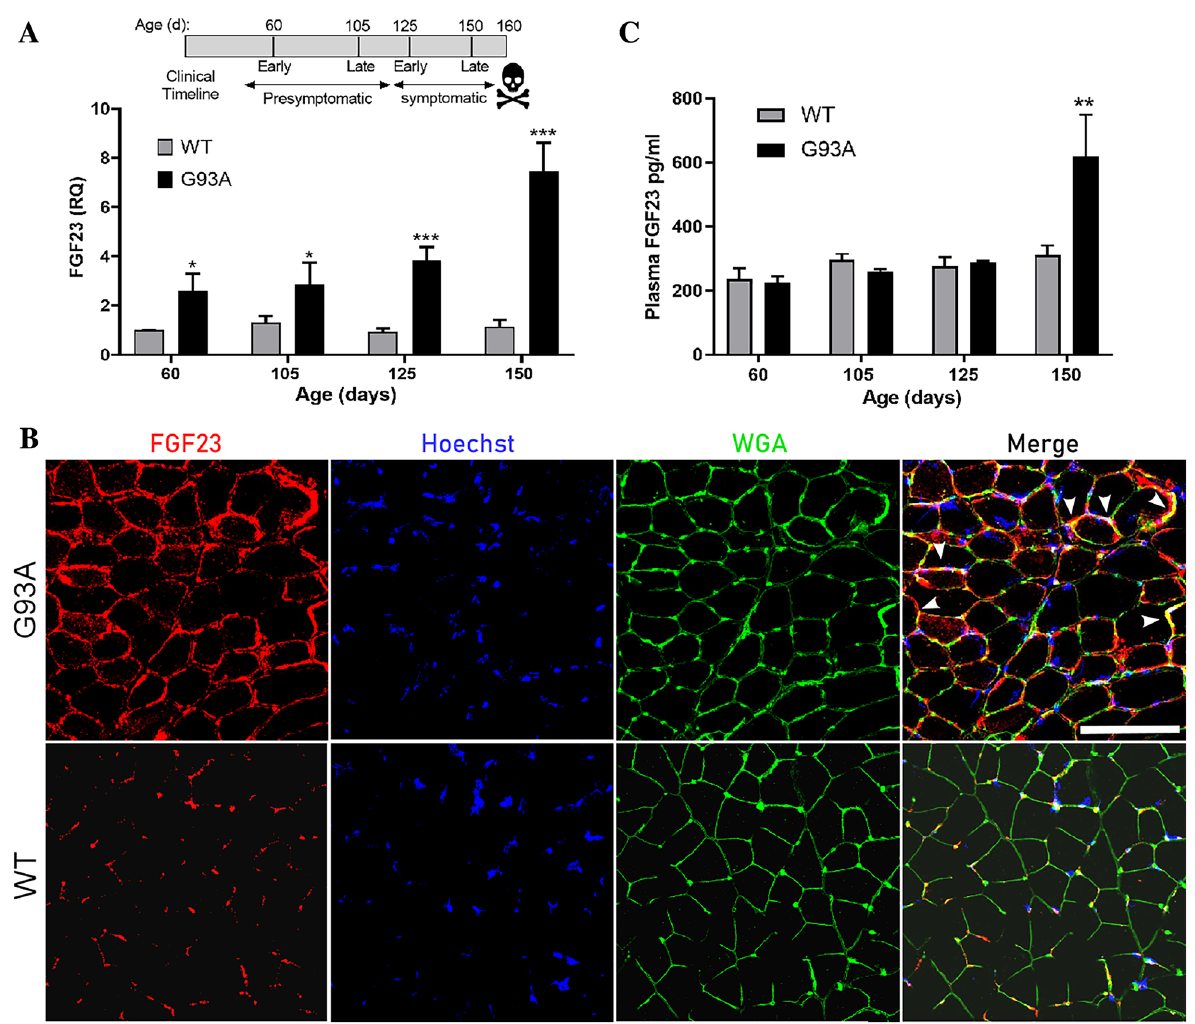
Figure 4. FGF23 is increased in SOD1 G93A muscle. ( A ) The clinical timeline of disease progression in the SOD1 G93A mouse is shown above 11 . Below is a qPCR analysis of gastrocnemius muscle samples from littermate controls (WT) and SOD1 G93A mice at different ages as indicated. Data points are the mean ± SEM of 6–8 mice. * P < 0.05, *** P < 0.0005. ( B ) Photomicrographs of gastrocnemius muscle sections from a WT and SOD1 G93A mouse (60 d) immunostained with an anti-FGF23 antibody and counterstained with Hoechst and WGA. Scale bar, 100 μm. Arrowheads highlight several areas of merged FGF23 and WGA staining. ( C ) ELISA analysis of FGF23 in plasma samples obtained at the ages indicated. Data points are the mean ± SEM of 3 mice per group. ** P <